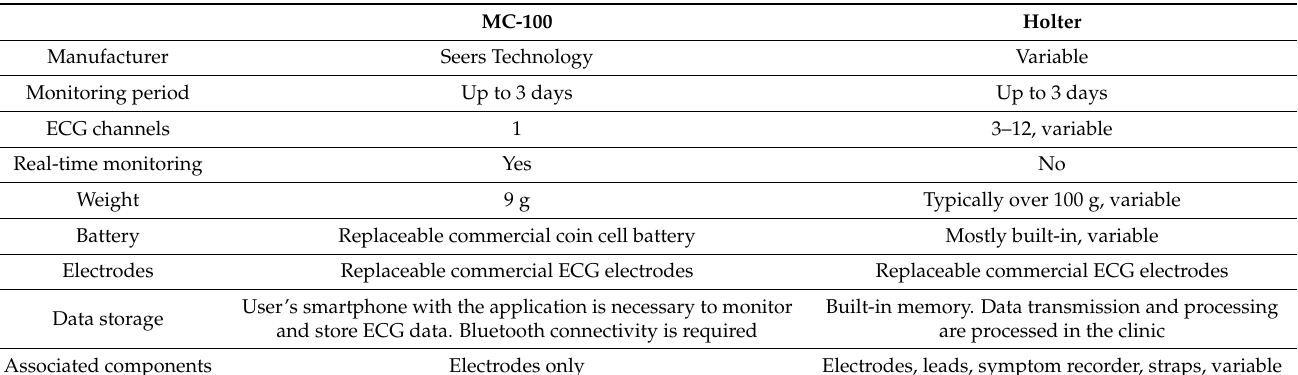
Table 6. Brief comparisons between the MC-100 and